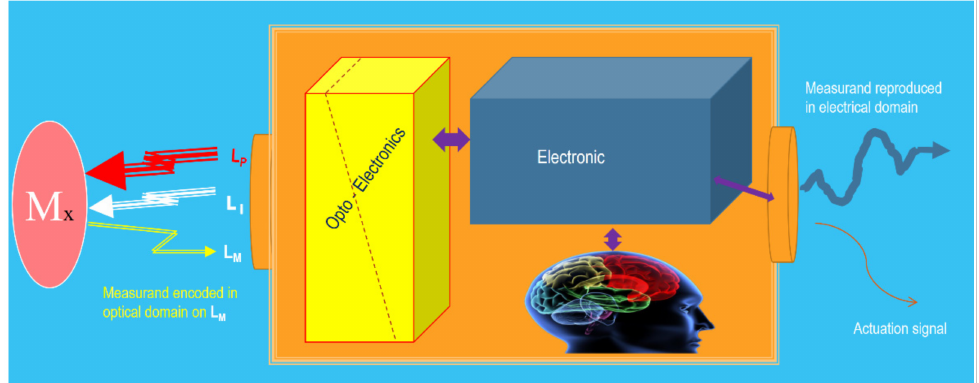
Figure 3. Illustration of the optoelectronic unit of a photonic sensor. It is in charge of producing and controlling the photonic beams or Light (if required) to carry out the object’s interrogation or/and pumping tasks. It is also in charge of achieving the photodetection, and all required additional processes, to reproduce the measurand in the electrical domain. When equipped with intelligence capable of giving an actuation signal, the sensing device is transformed into a Smart Photonic Sensor (SPS). Courtesy of the